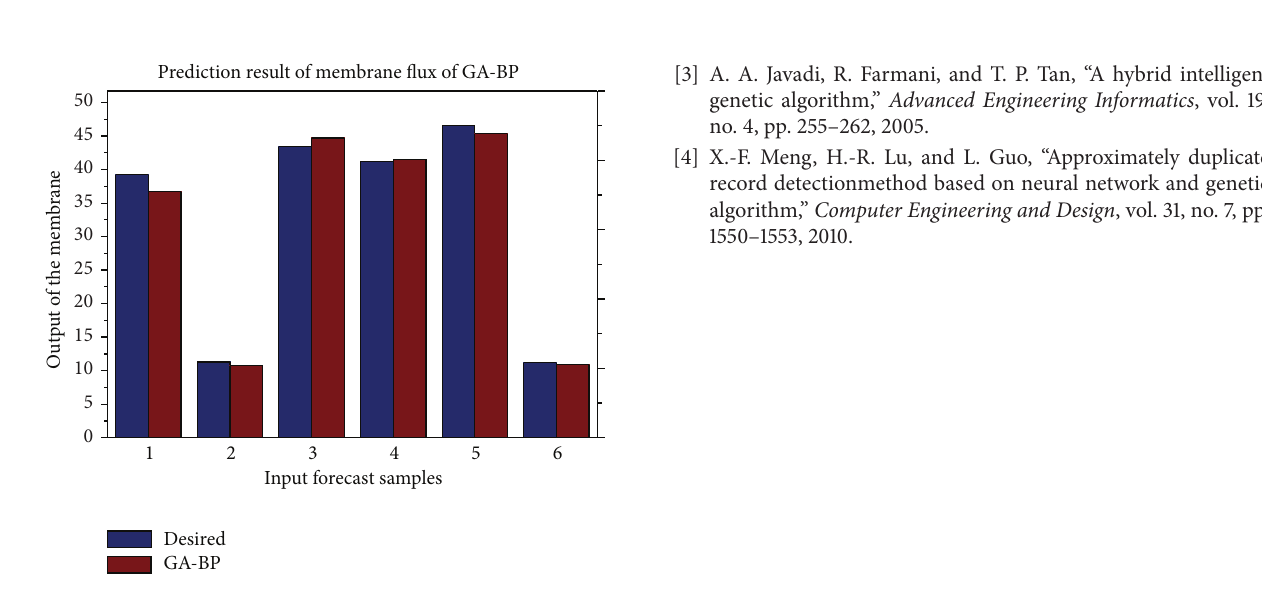
Figure 4: Predicted and measured values of the GA-BP membrane